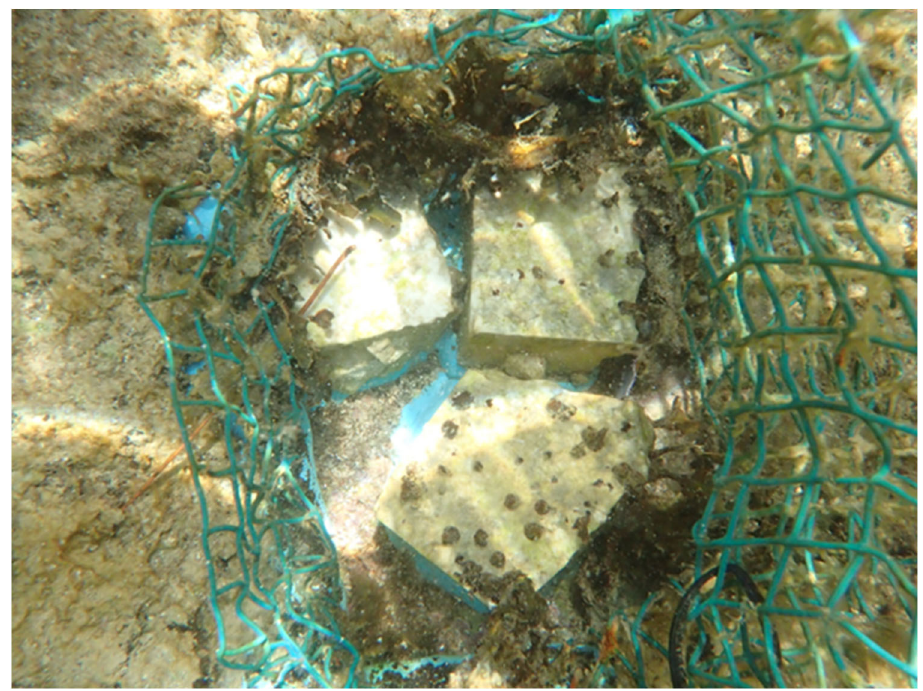
Figure 5. Destroyed anti-grazer cage with consumed Fucus virsoides.